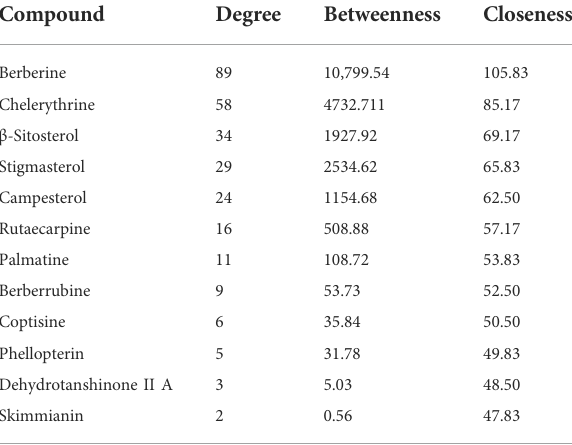
TABLE 3 Active ingredients and topological